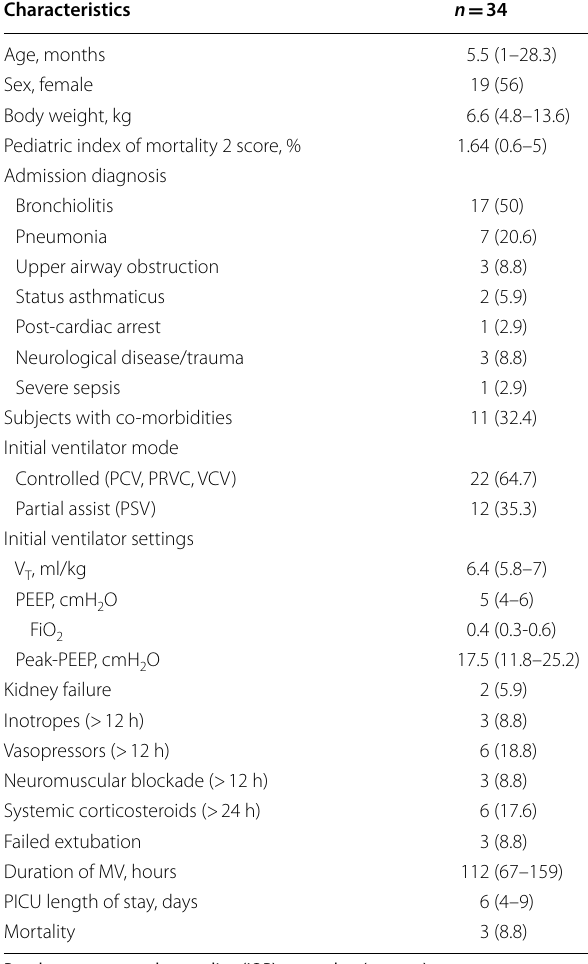
Table 1 Patient characteristics for overall study